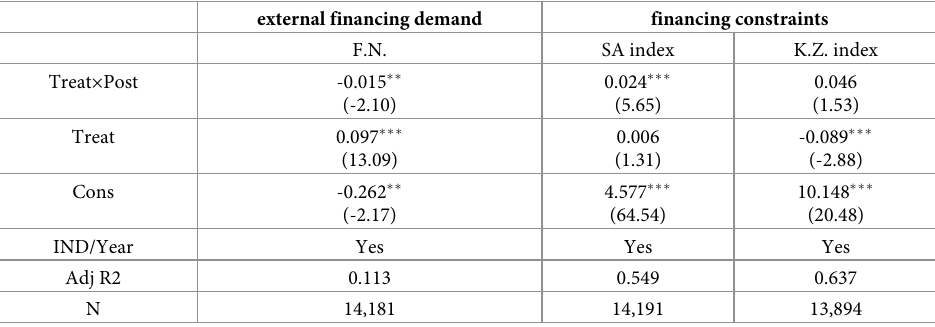
Table 8. Alternative explanations: Active adjustment or passive change.